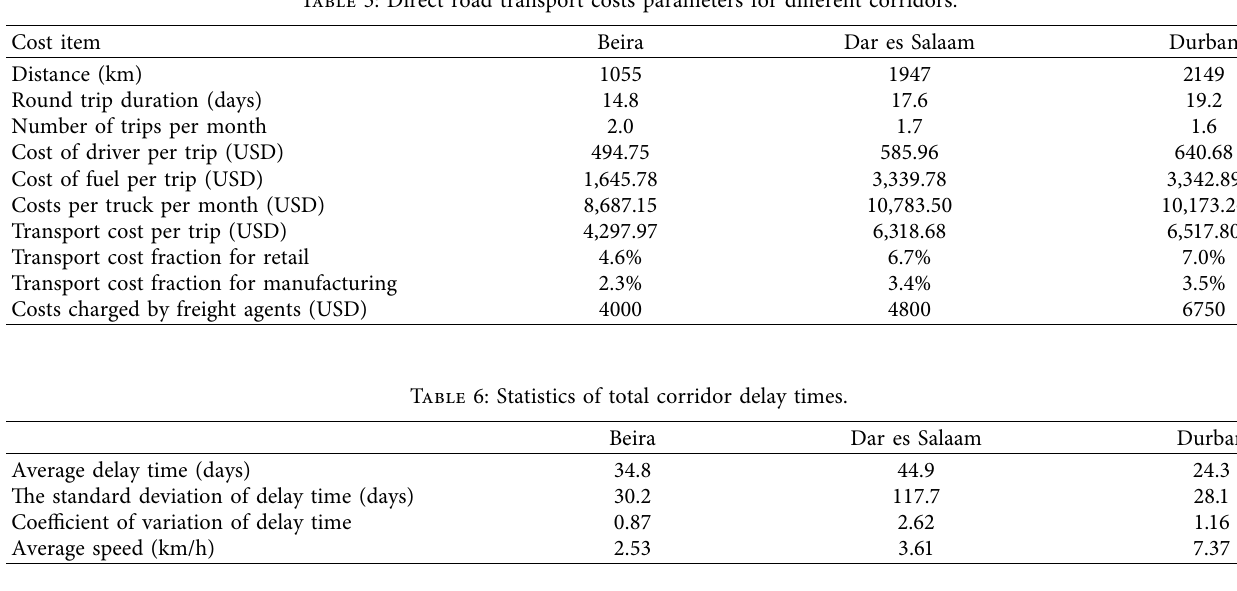
Table 5: Direct road transport costs parameters for diferent corridors.